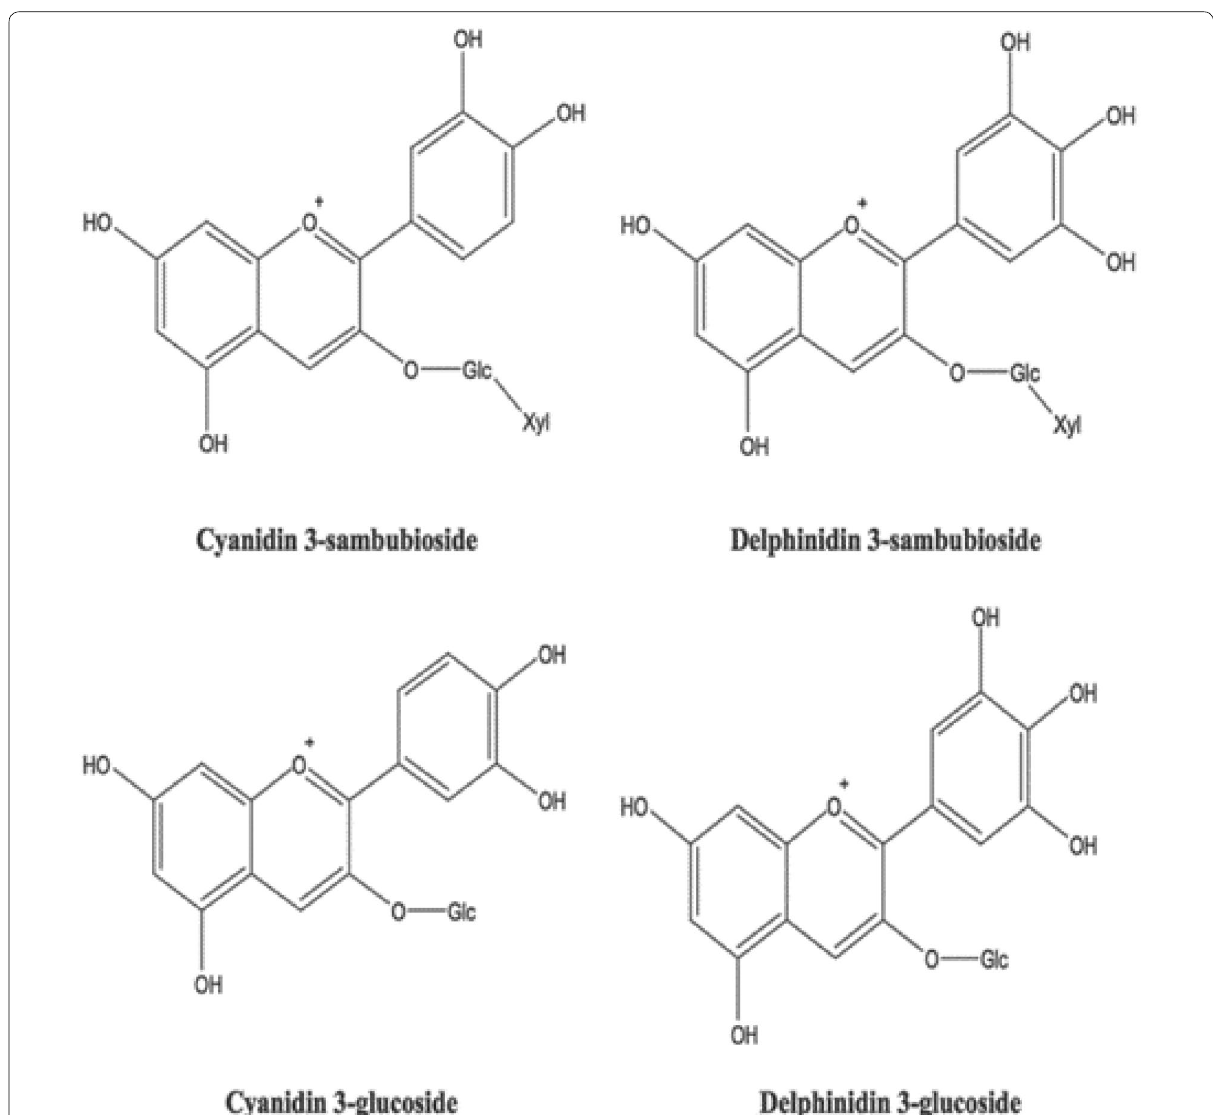
Fig. 10 Chemical structures for anthocyanin compounds found in Hibiscus